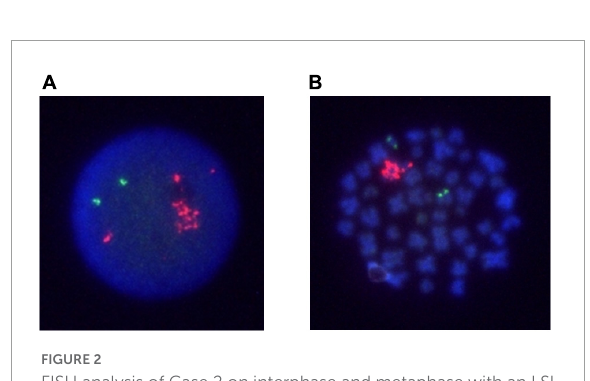
FIGURE2 FISH analysis of Case 2 on interphase and metaphase with an LSI ETV6/RUNX1 ES dual color probe. RUNX1 signals are in red, and ETV6 signals are green. (A) An interphase cell at relapse. (B) A metaphase cell at